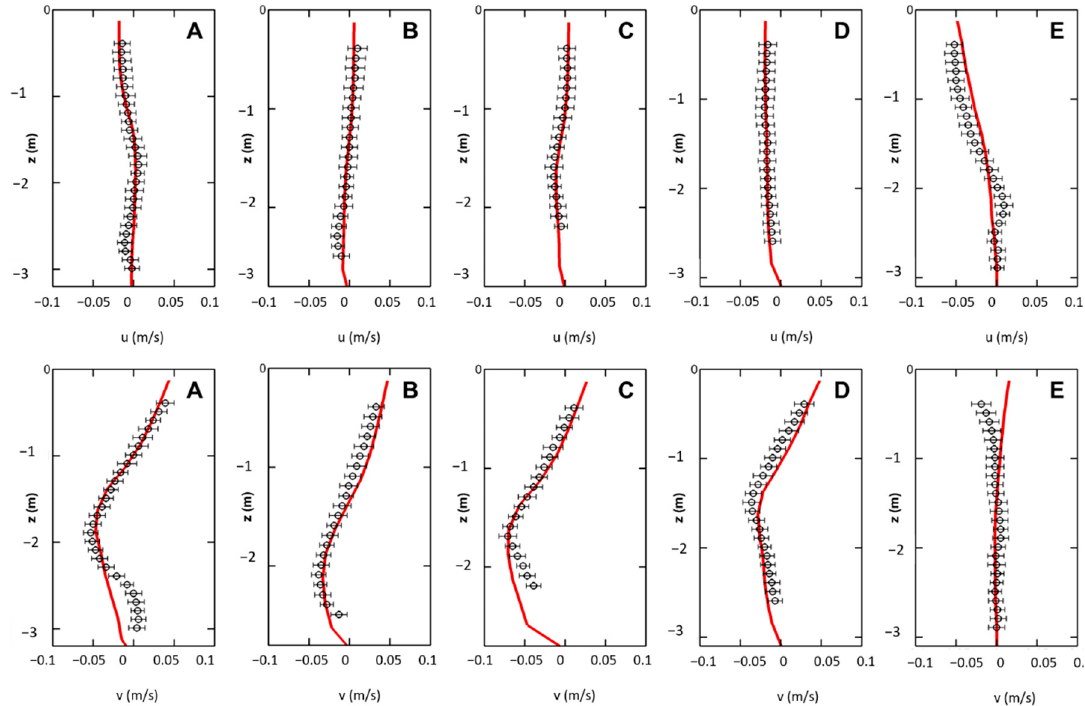
Figure 4. Comparison of eastward ( u ) and northward ( v ) velocity component profiles on the upper and lower panels, respectively, between modelled results (solid lines) and field observations (circles) with error bars at the five velocity measurement locations (see A , B , C , D , and E in Figure 1). Model results are averaged over the 5-hour measurement interval, while observations represent half hour averages.